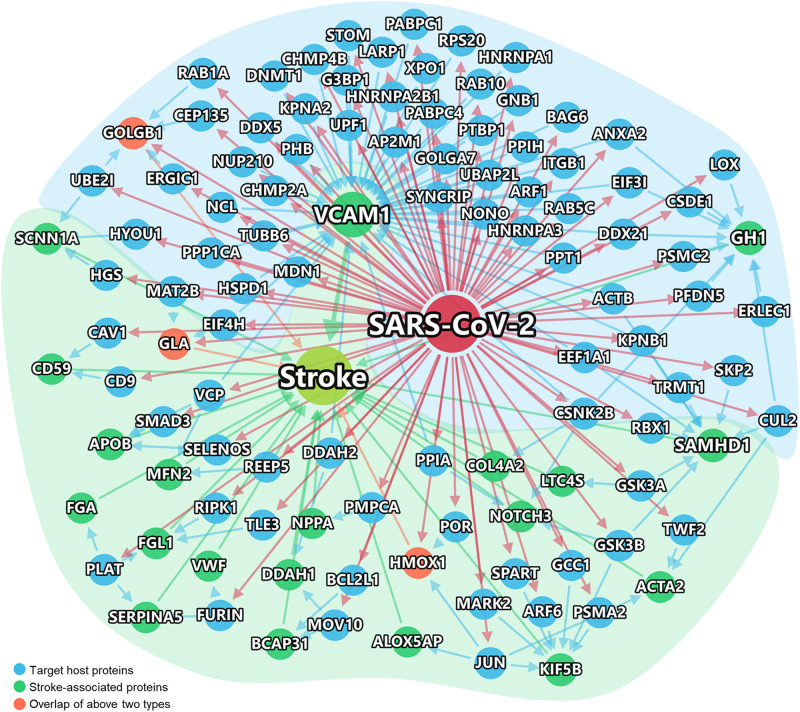
Network-inferred inflammatory endophenotypes shared by stroke and COVID-19. Virus target genes are shown in Blue. The stroke-associated genes were shown in Green. Stroke-associated genes which were also the direct targets of the virus, shown in Orange. The links between genes/proteins denote the physical protein-protein interactions (including SARS-CoV-2 viral protein and human protein interactions, and human protein-protein interactions).